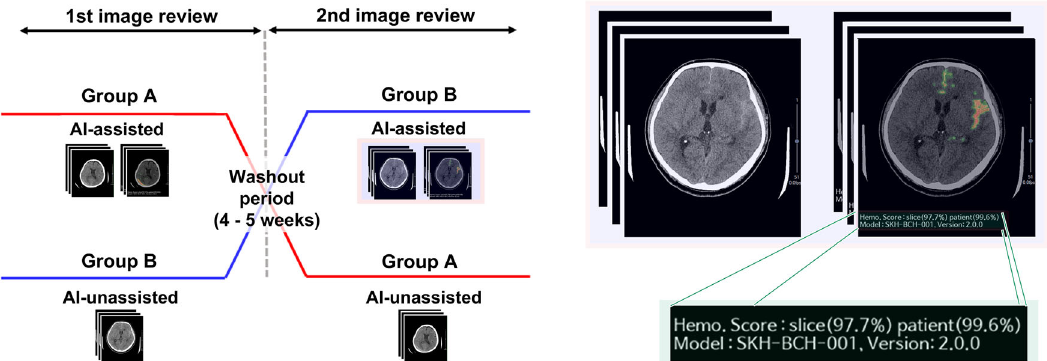
Fig. 5 Schematic overview of study design. The schematic diagram shows the retrospective, pivotal, crossover, randomised study design used in the present study (left). In the fi rst image review, group A consisted of original CT images and corresponding AI-assisted CT images, while group B consisted of only the original CT images without AI-assisted CT images. After a washout period of 4 – 5 weeks, in the second image review, the group A dataset was changed to include only the original CT images without any AI-assisted CT images, while AI-assisted CT images were added to the group B dataset. The AI-assisted CT images provided a heatmap with information on the suspected location and probability of AIH in a patient- and slice-wise manner